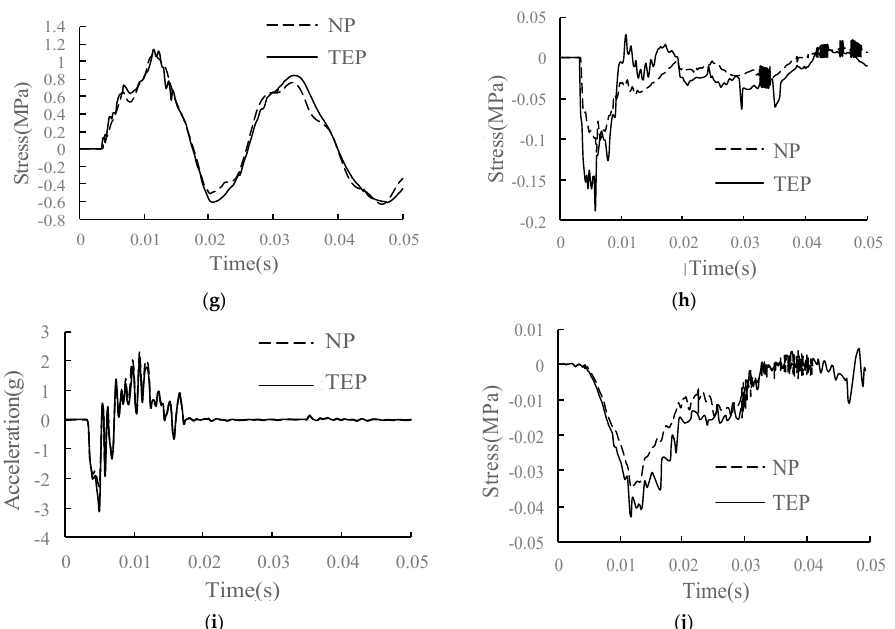
Figure 19. Dynamic response diagram of each structural layer in the condition of TEP: ( a ) wheel–rail vertical force; ( b ) rail acceleration; ( c ) rail vertical speed; ( d ) rail vertical displacement; ( e ) track slab acceleration; ( f ) acceleration of SCC layer; ( g ) longitudinal stress of SCC layer; ( h ) vertical stress of SCC layer; ( i ) base acceleration; ( j ) vertical stress of substructure.